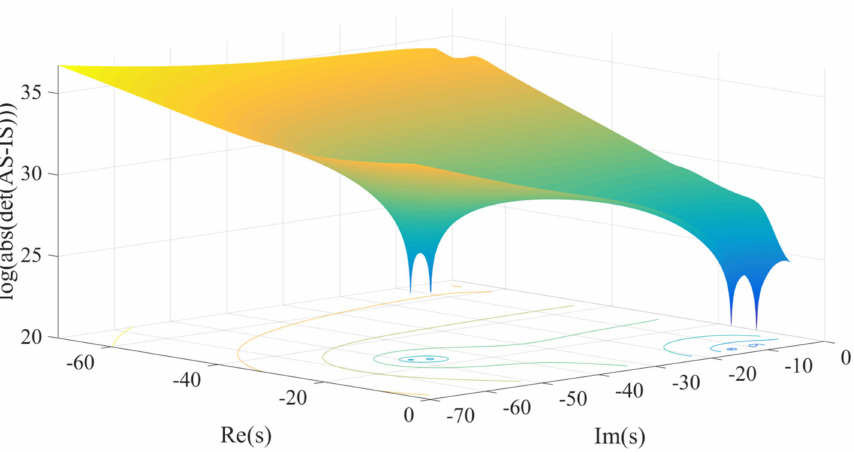
Figure 6. Three-dimensional plot showing the four approximate roots of the characteristic equation of the HIIRS-equipped